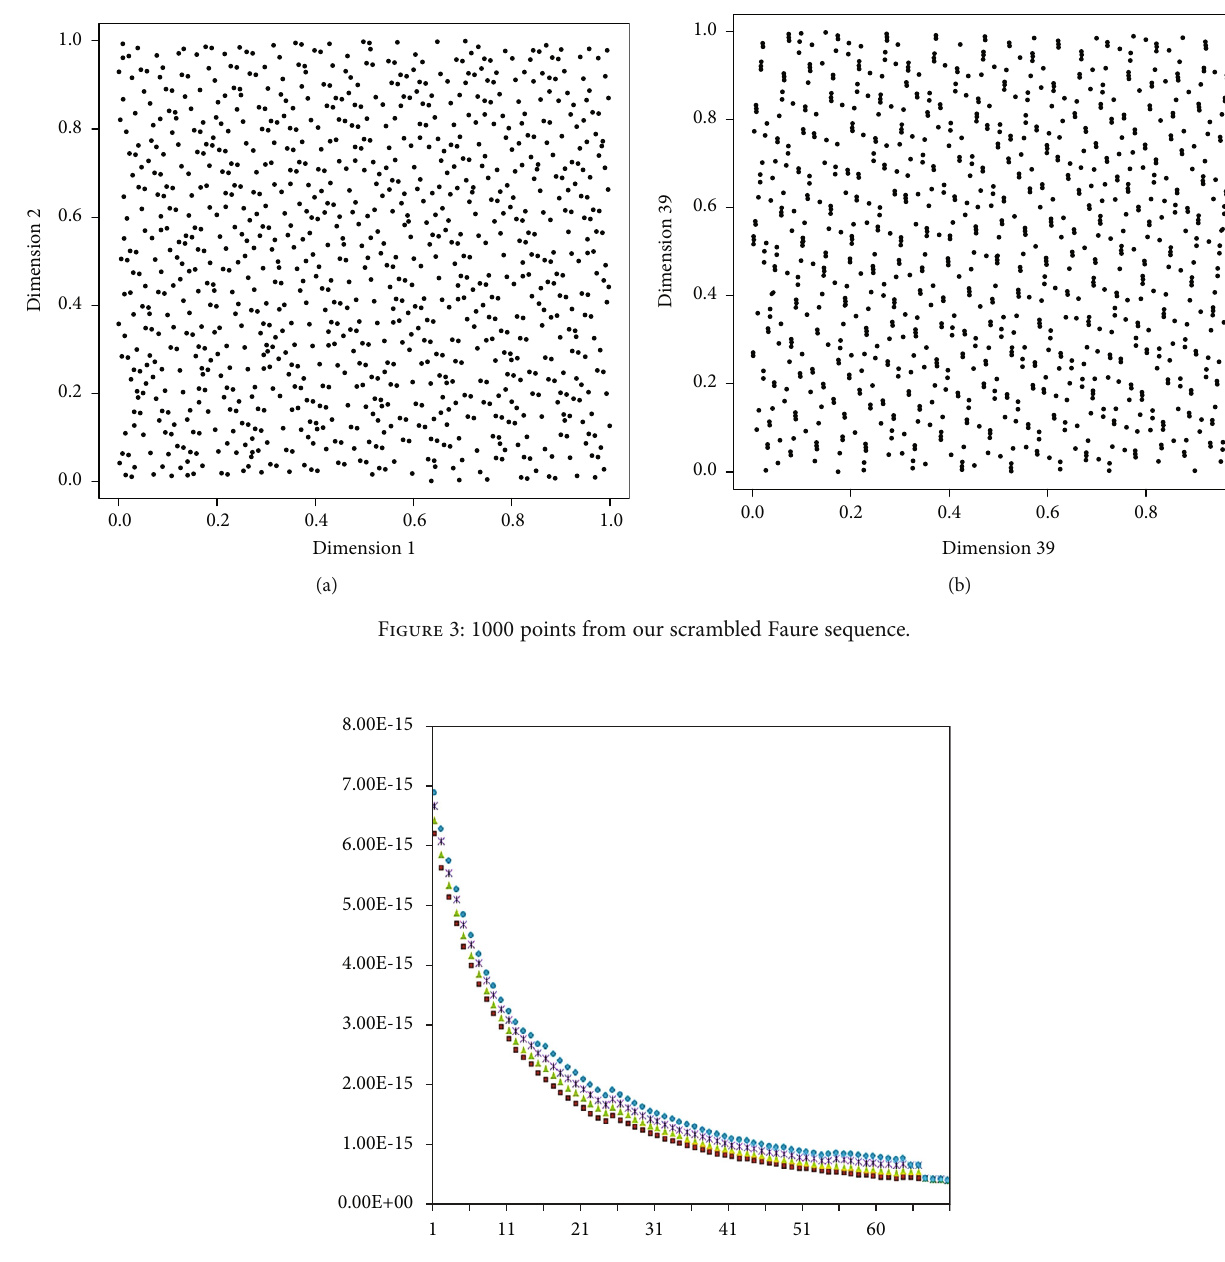
Figure 4: L -discrepancy for various randomized scramblings of a 40-dimensional Faure sequence. 2